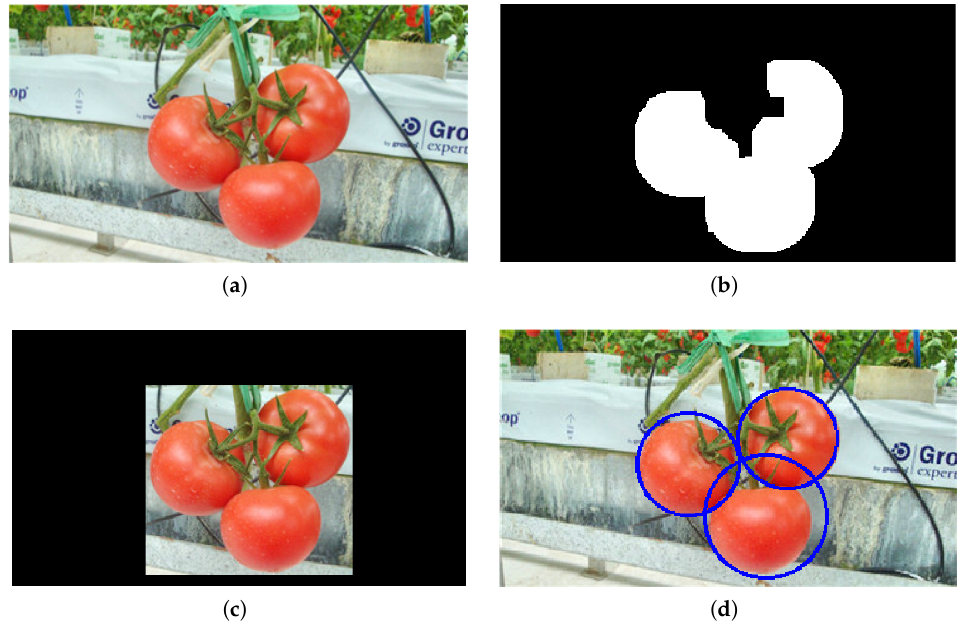
Figure 10. An example of scanning method 2: ( a ) an original image, ( b ) the results after NB classification and the morphological process, ( c ) the extracted region of interest (ROI), and (d) the detection results.